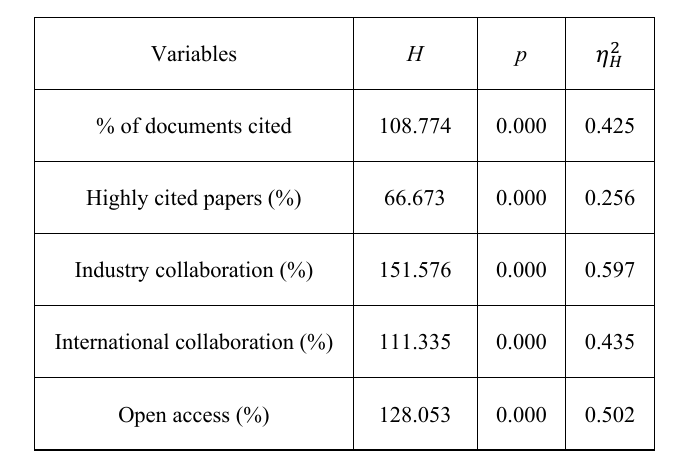
Table 3. The Kruskal-Wallis test results for other